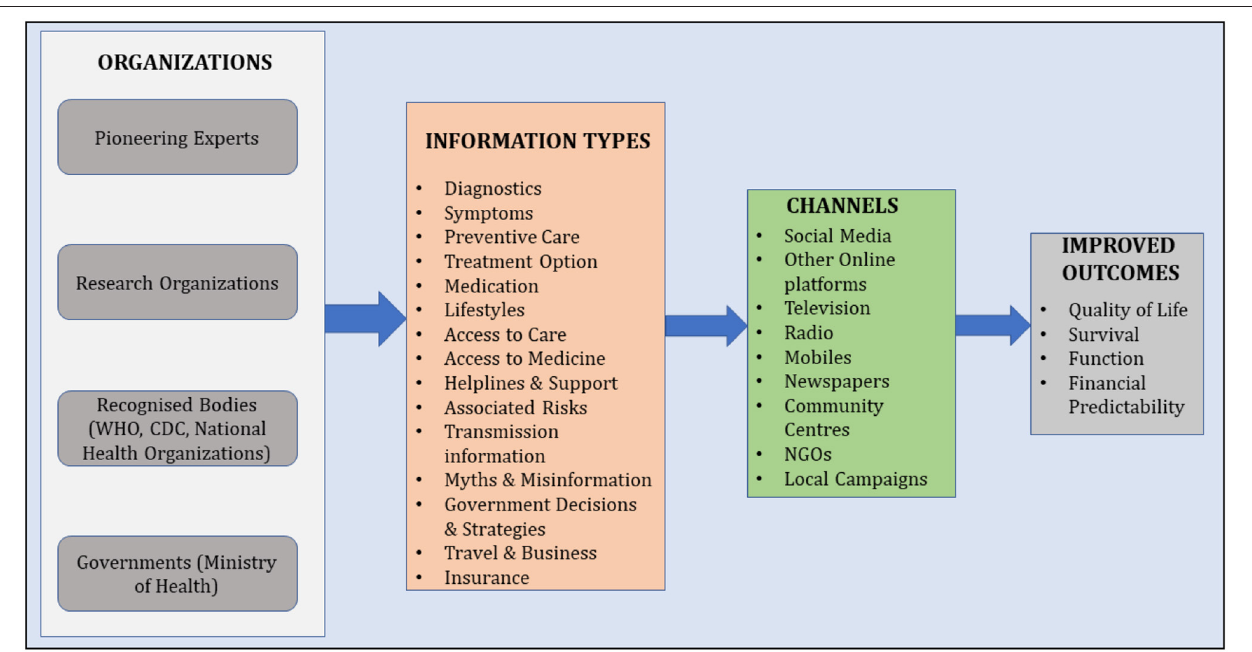
FIGURE 1 | Framework for public awareness during COVID-19